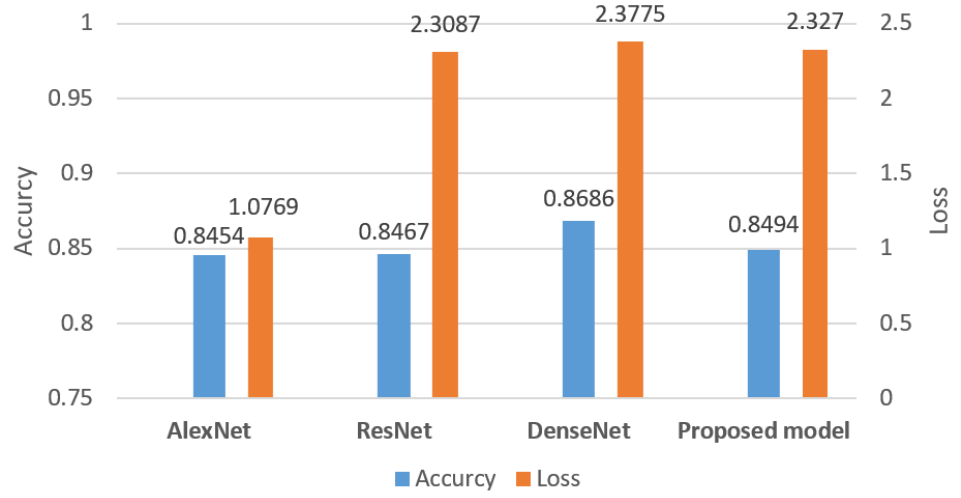
Figure 14. Performance evaluation of neural network models using crawling data (average accuracy and loss value).